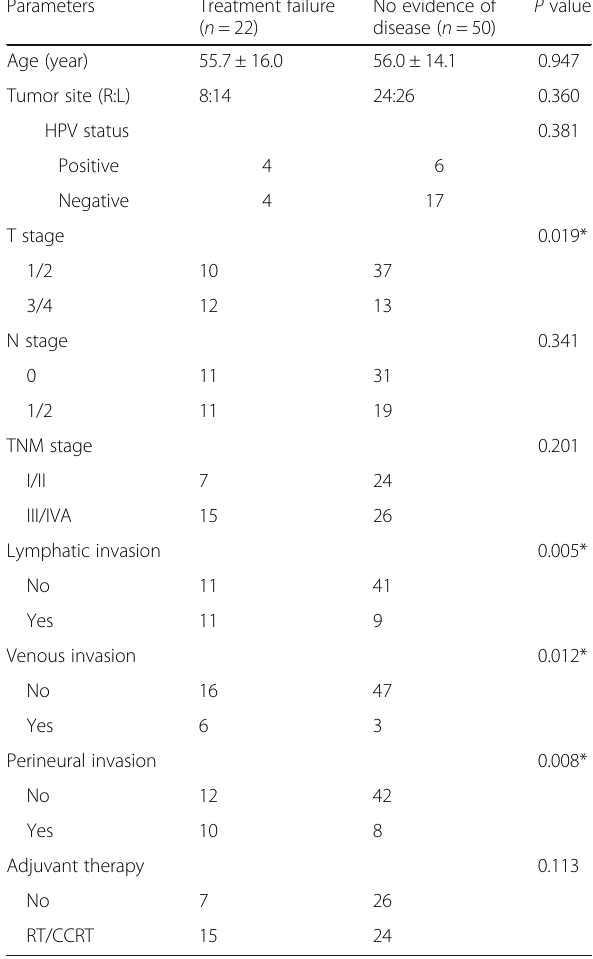
Table 2 Comparison of clinicopathologic parameters according to head and neck cancer treatment failure after surgery Parameters